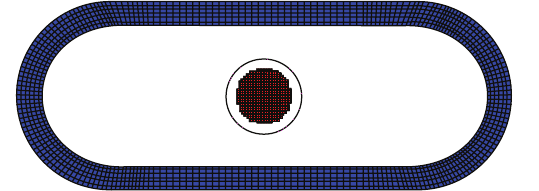
Figure 6: Two-dimensional expanding tube numerical model.